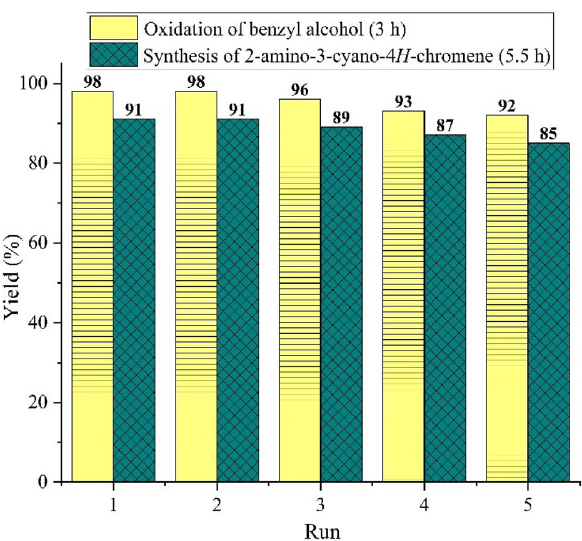
Figure 19. Recyclability of (γ-Fe 2 O 3 -Im-Py) 2 WO 4 catalyst in the oxidation of benzyl alcohol and also in the preparation of functionalized 2-amino-3-cyano-4 H -chromene via multicomponent TOP in the model reaction, under optimized reaction